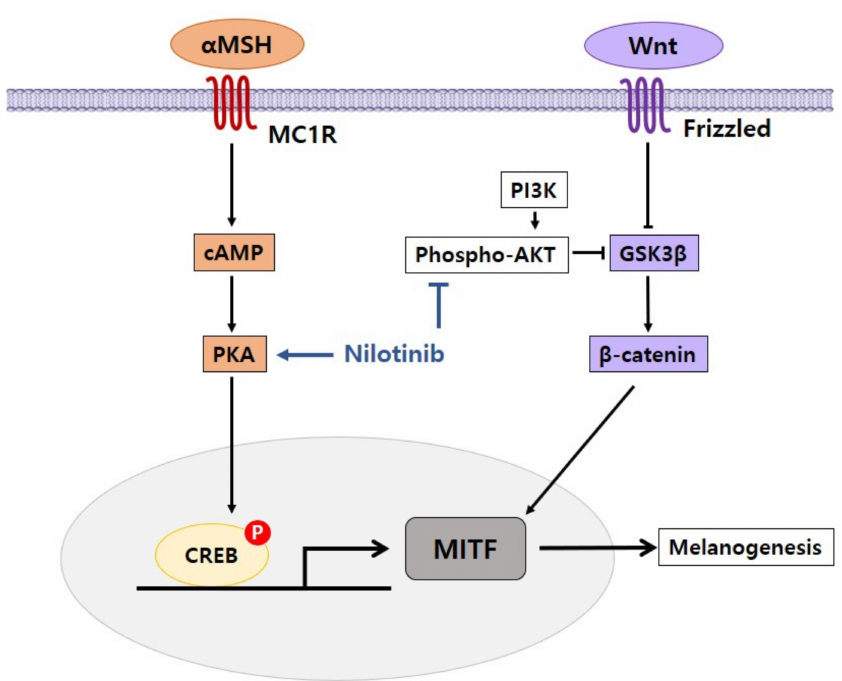
Figure 3. Proposed mechanism of nilotinib in the regulation of pigmentation. Nilotinib enhances melanogenesis by inhibiting phospho-AKT and activating